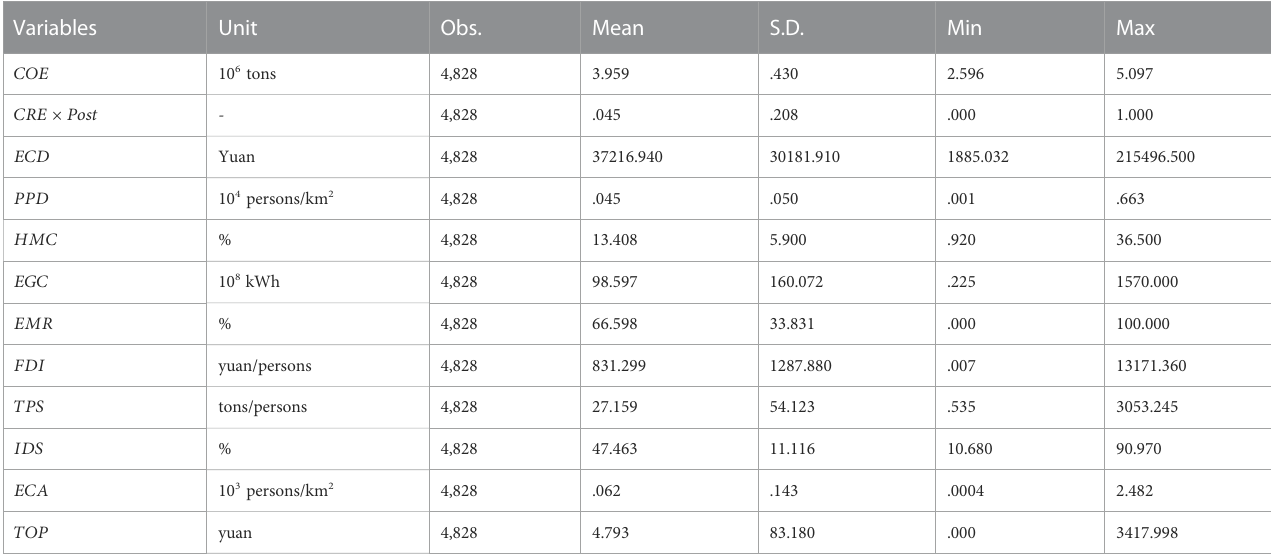
TABLE 1 Descriptive statistics of